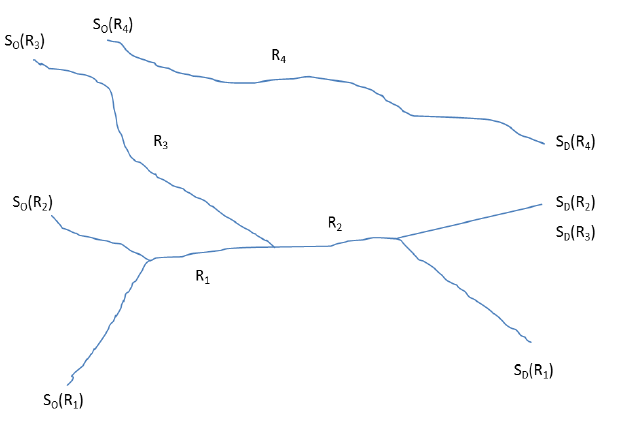
Figure 5. Some possible stop sequence ambiguity along different routes: S O ( R i ) and S D ( R i ) denote